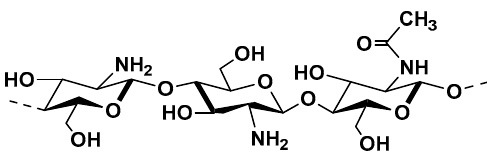
Figure 12. Chemical structure of chitosan.